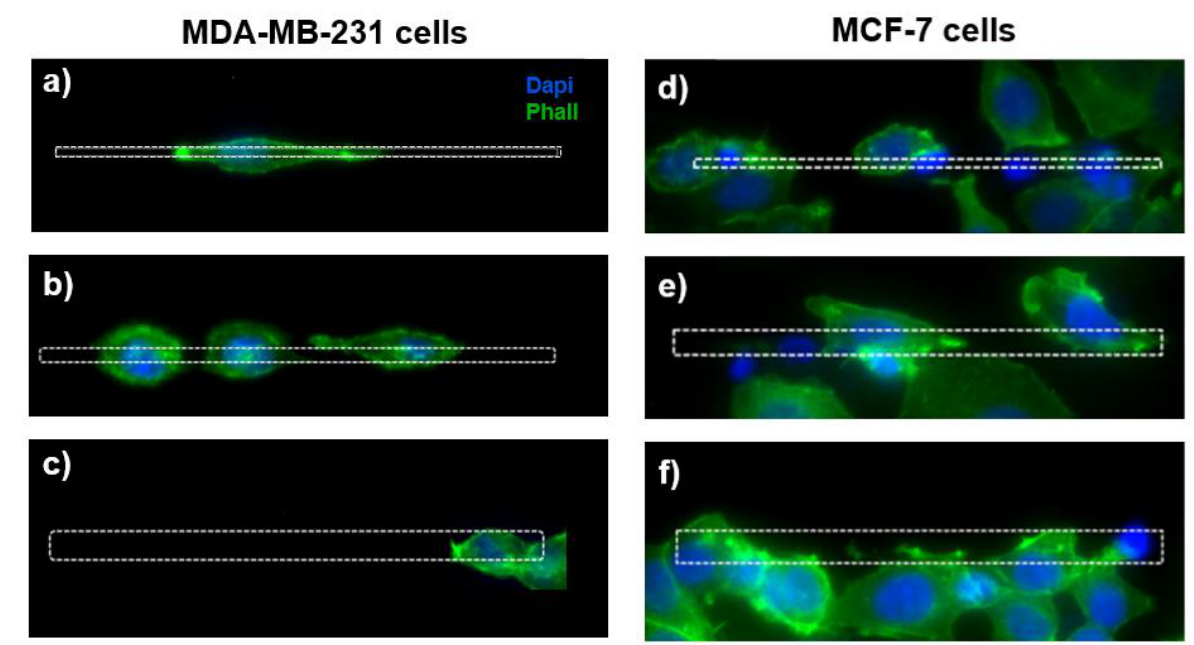
Figure 4. On the left, the fluorescence images of MDA-MB-231 cells grown on micro-gaps with different gap size. Cells on gaps 2 µ m wide ( a ) appear more elongated than in gaps 4 µ m ( b ) and 8 µ m ( c ) wide. On the right, the fluorescence images of MCF-7 cells’ fluorescence images cultured on the 2 µ m ( d ), 4 µ m ( e ), and 8 µ m ( f ) wide structures. Green—actin cytoskeleton (stained with Phalloidin); blue—nuclei (stained with DAPI).